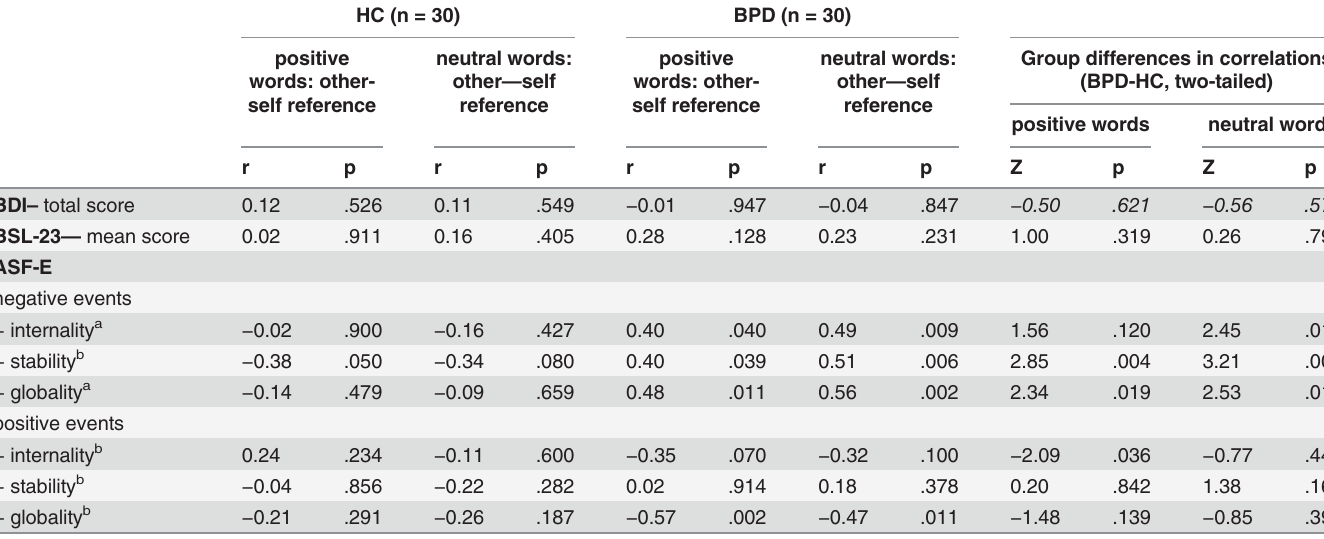
Table 4. Pearson correlation between alterations in self-referential processing in the valence judgment task and attributional style in healthy control participants (HC) and patients with Borderline Personality Disorder (BPD).